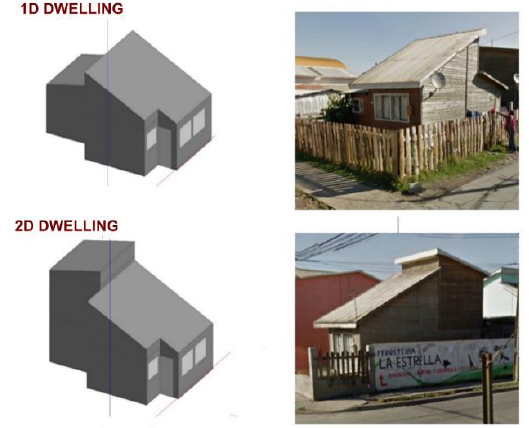
Figure A5. Geometry and pictures of the 1D and 2D dwellings (authors’ own preparation).